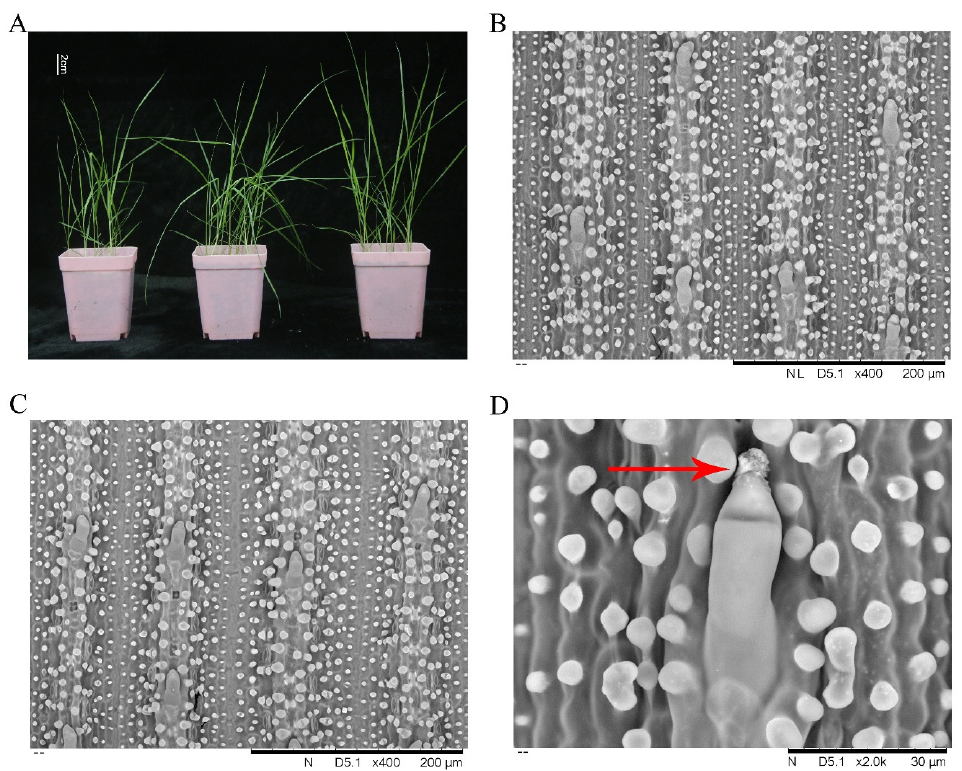
Figure 1. Salt secretion and ultrastructure characteristics of salt glands (microhairs) in Z. macrostachya under SEM. A salt gland of Z. macrostachya consists of a pair of cells. The longer cell located in the lower position is basal cell, the approximately triangular cell at the top is cap cell. ( A ) seedlings of Z. macrostachya (2-month-old). ( B ) distribution of salt glands on adaxial surfaces in control group. ( C ) distribution of salt glands on adaxial surfaces in NaCl-treated group. ( D ) salt glands on adaxial surfaces under 300 mmol/L NaCl. The arrow points to a grain of crystal. Table 1. Element (Na, Ca, K, Cl) content (weight %) of the salt gland (basal cell and cap cell) in the control group and 300 mmol/L NaCl-treated group (24 h). Element content measured by X-ray energy spectrum. Results were presented as a percentage. Means (± SD) were calculated from three replications ( n = 3) for each group. -: represents undetected.